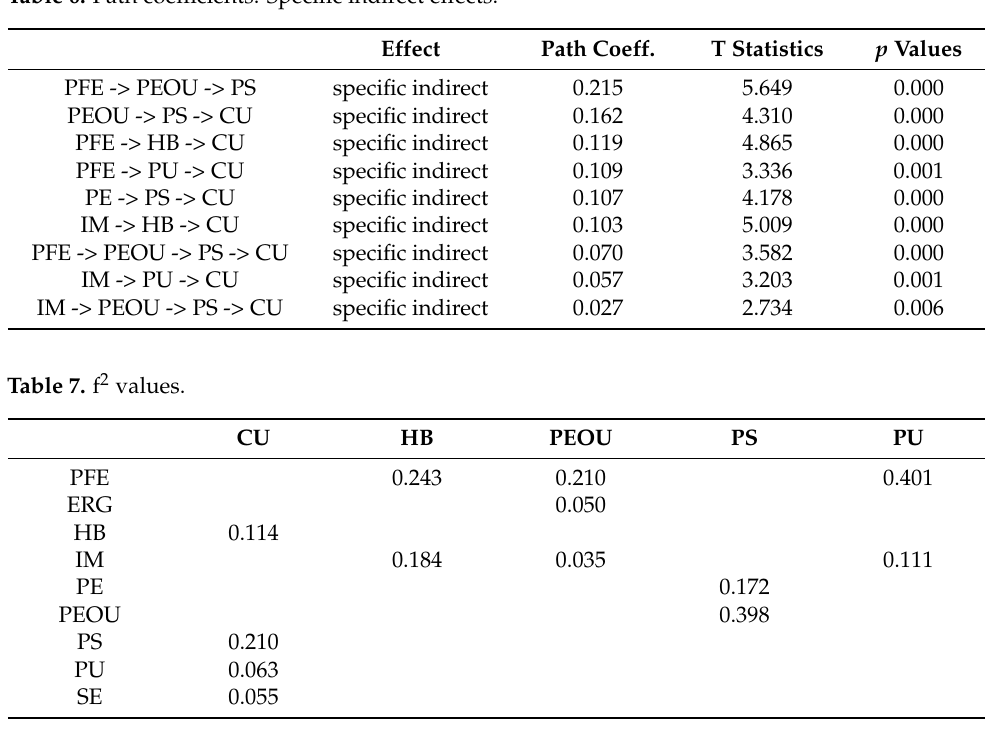
Table 6. Path coefficients. Specific indirect effects.